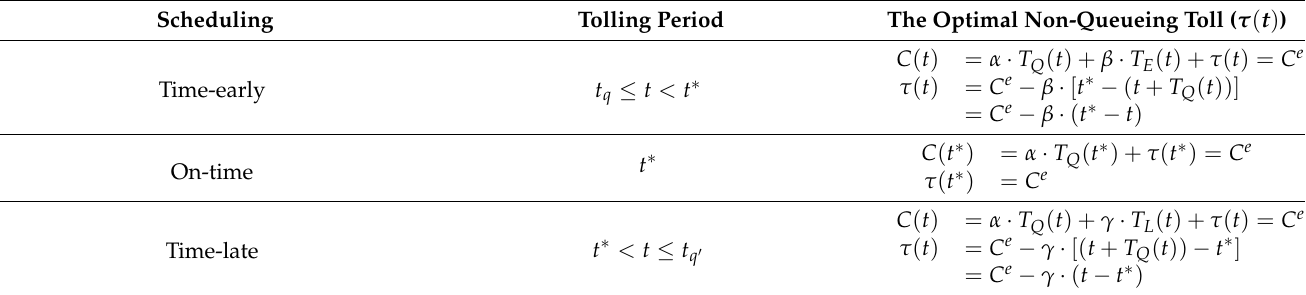
Table 3. Derivation of the optimal non-queueing toll scheme.